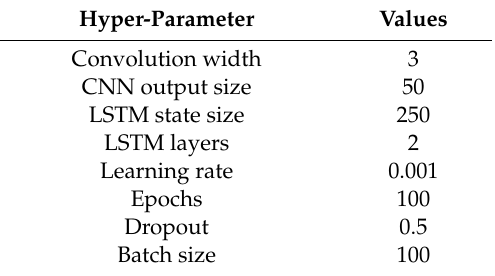
Table 6. The parameters for our